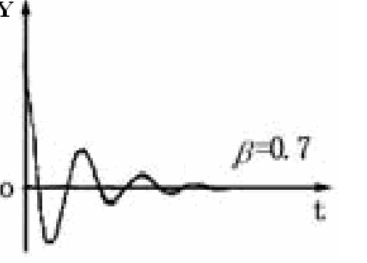
Figure 12. Underdamped vibration curve of traveling mechanism acceleration.